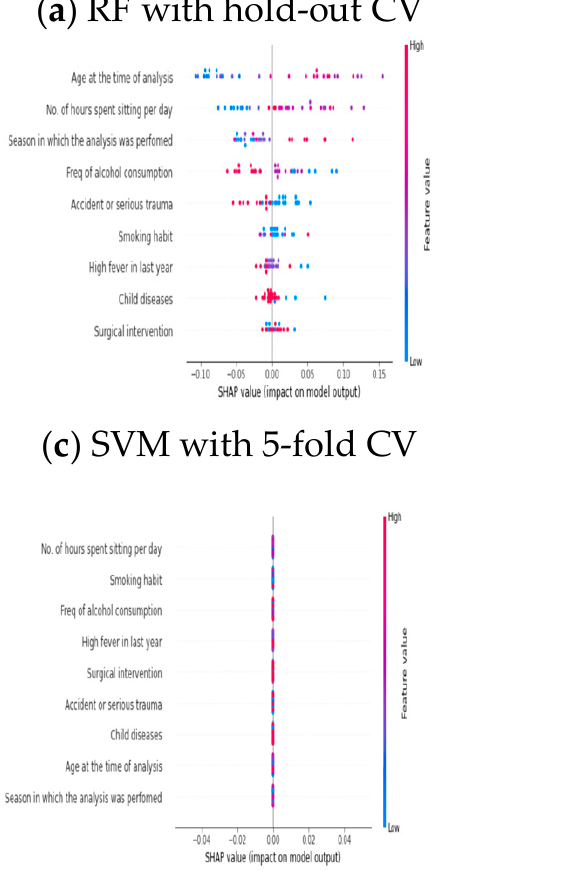
Figure 4. SHAP Explanation for Imbalance